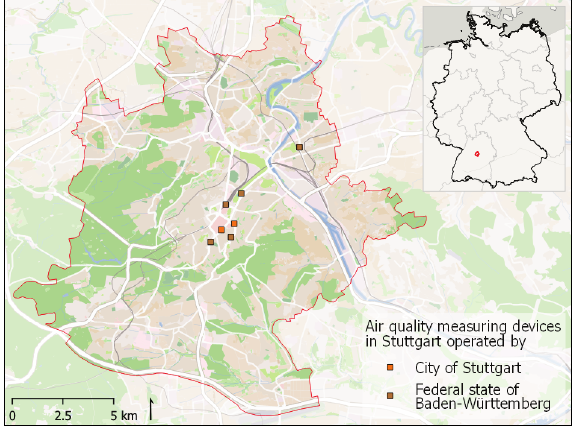
Figure 2: Measuring devices in the City of Stuttgart (Source: